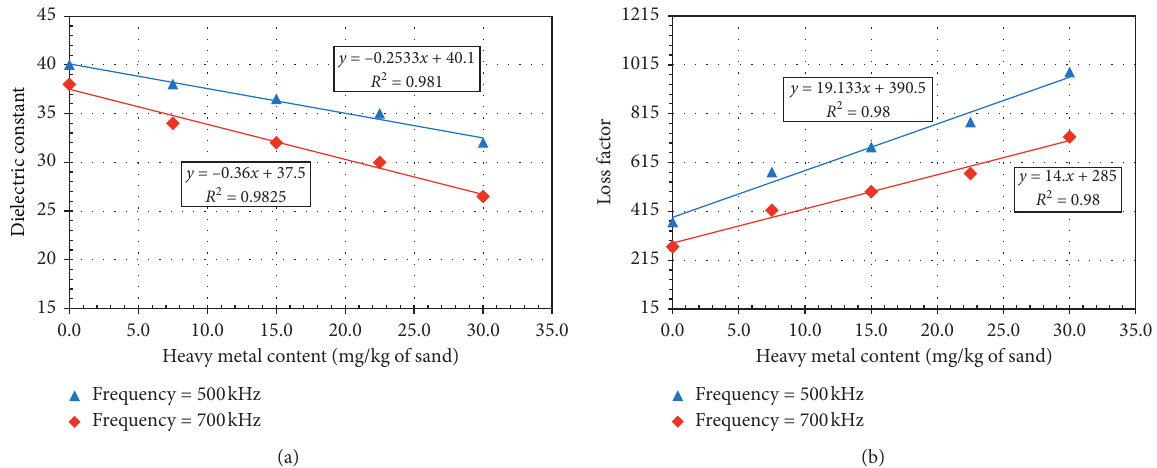
Figure 7: Regression analysis of complex permittivity and Pb content. (a) Dielectric constant versus Pb content. (b) Loss factor versus Pb content.